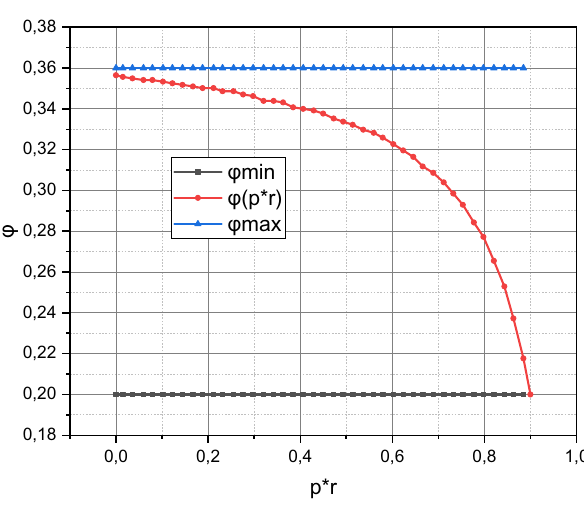
Figure 4. The calculated dependence ϕ ≈ =